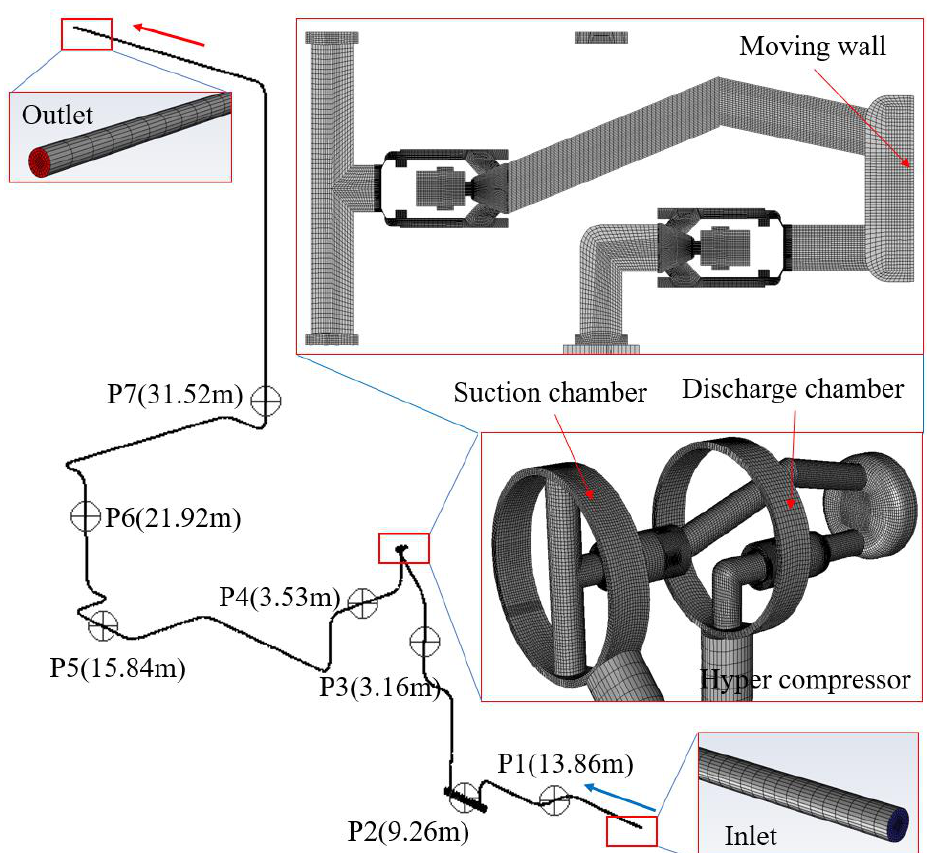
Figure 2. Meshes for the hyper compressor and its pipelines.